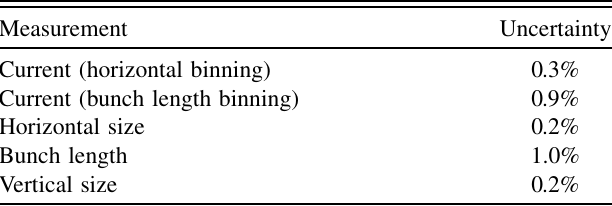
TABLE III. Approximate statistical uncertainties at high current.